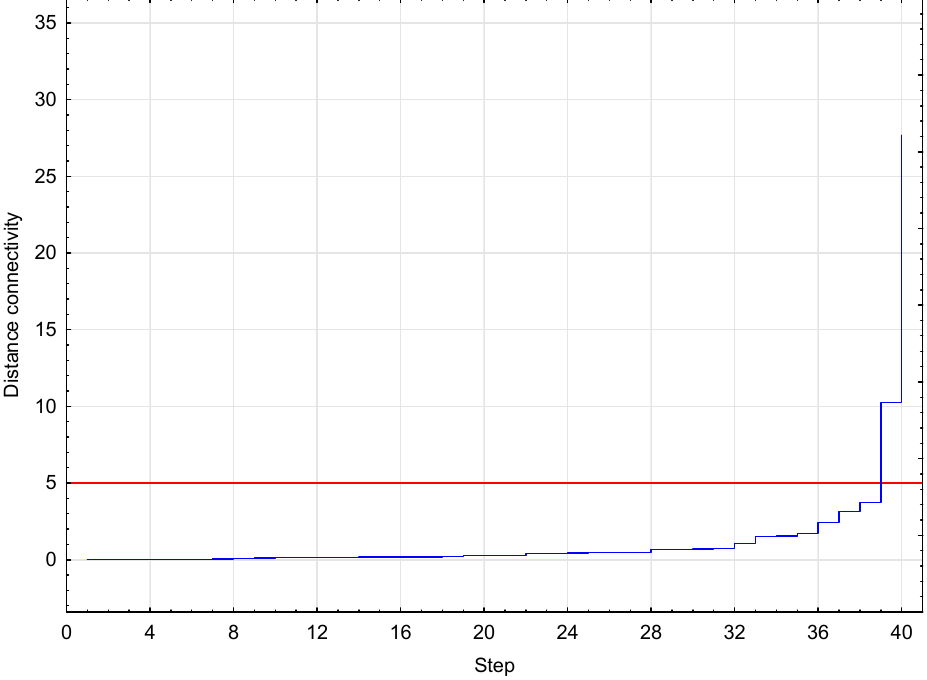
Figure A2. Clustering-over-time graph for the result presented in Figure 16: Agglomerative hierar- chical clustering using Ward's Linkage and Euclidean distance. Blue line–Clustering-over-time graph, Red line–shows place where the clusters were split.